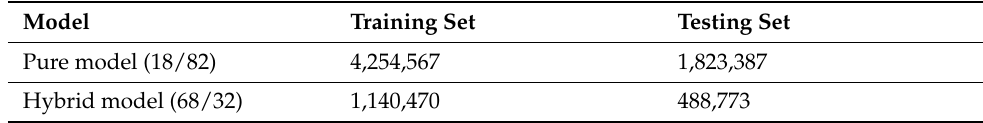
Table 2. Number of samples for each experiment and